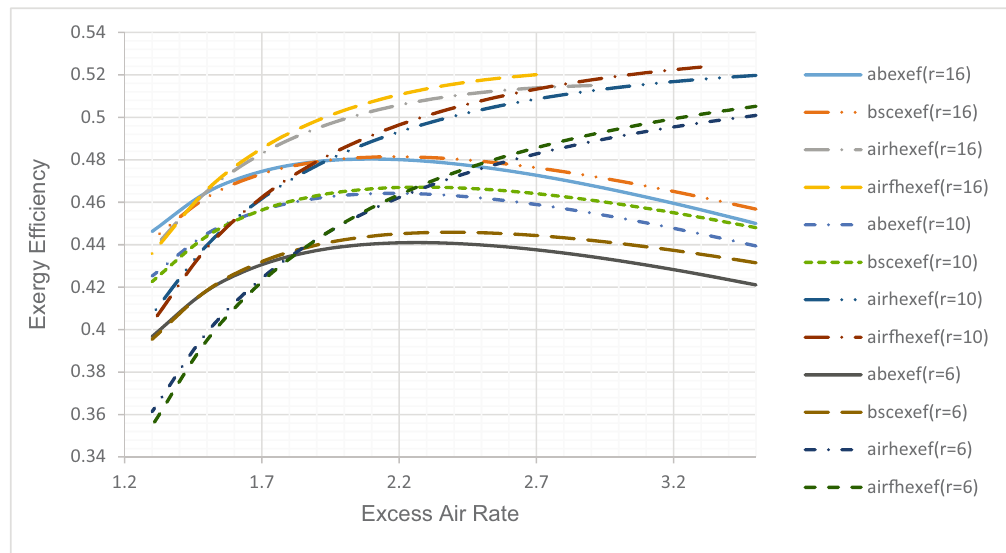
Figure 7: Variation of the exergy e ffi ciency with air excess coe ffi cient at di ff erent compressor compression ratios for basic ( bsc ) , absorption cooling ( ab ) , air ( airh ) , and air fuel ( airfh ) heating cogeneration cycles ( m fuel = 1.64 kg/s, η isC = η isT = 0.86, T recout = 850 K, T steam = 485.57 K, T = 426 K, and T = 298.15 K ) Exh ambi.